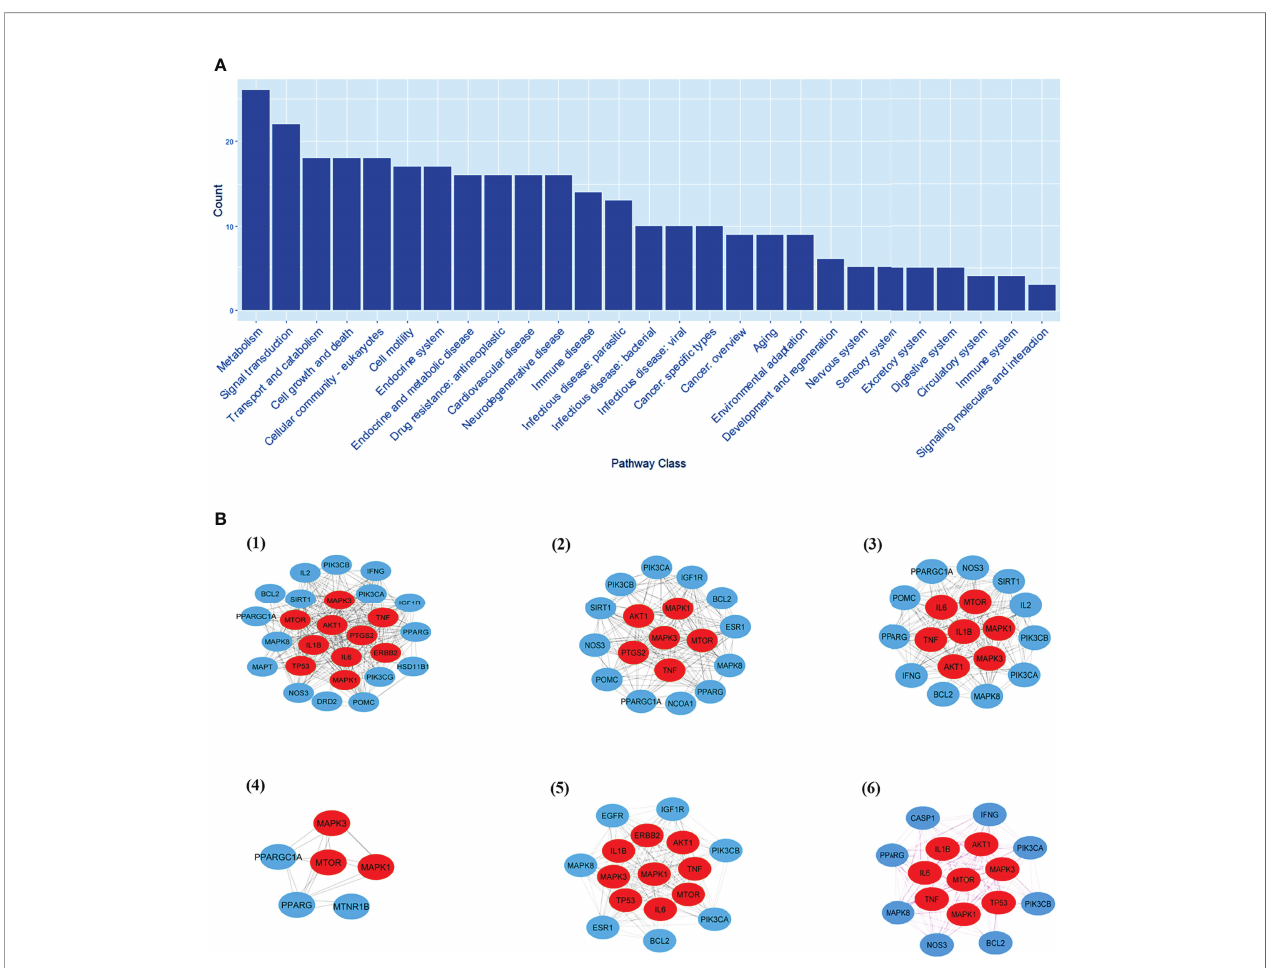
FIGURE 8 | The KEGG pathway class analysis. (A) The KEGG pathway class analysis of top 33 targets. ( B , 1-6) Subnetworks of major pathway classes.